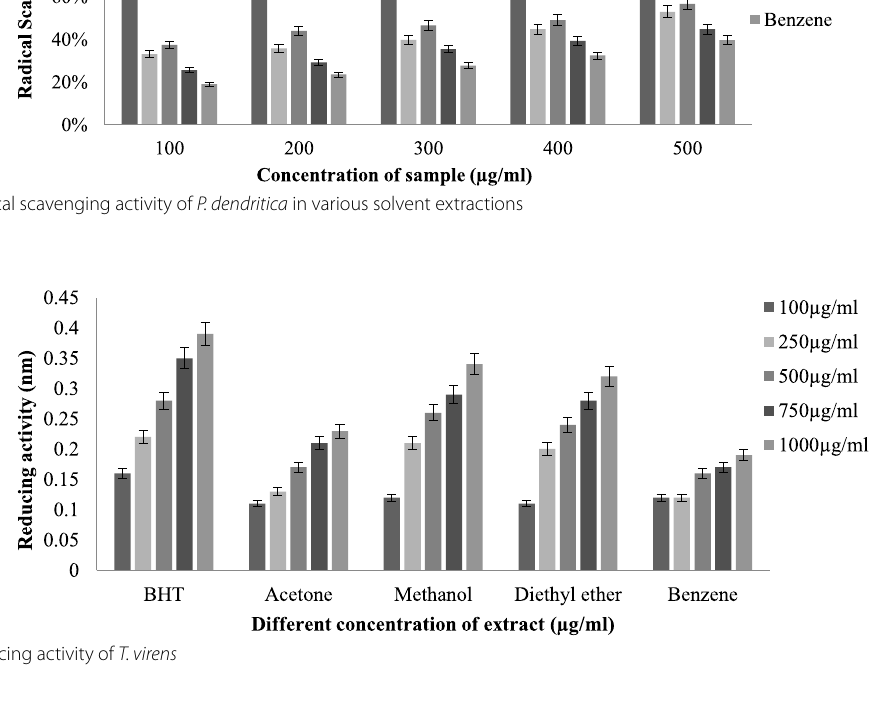
is taken to signify the evolutionary history of the taxa (for both species). This analysis involved 12 nucleotide ( P. dendritica ) and 16 nucleotide ( T. virens ) sequences (Fig. 4). All ambiguous positions were removed for each sequence pair (pairwise deletion option). There was a total of 541 positions ( T. virens ) and 1238 positions ( P. dendritica) in the final dataset (Fig. 5).